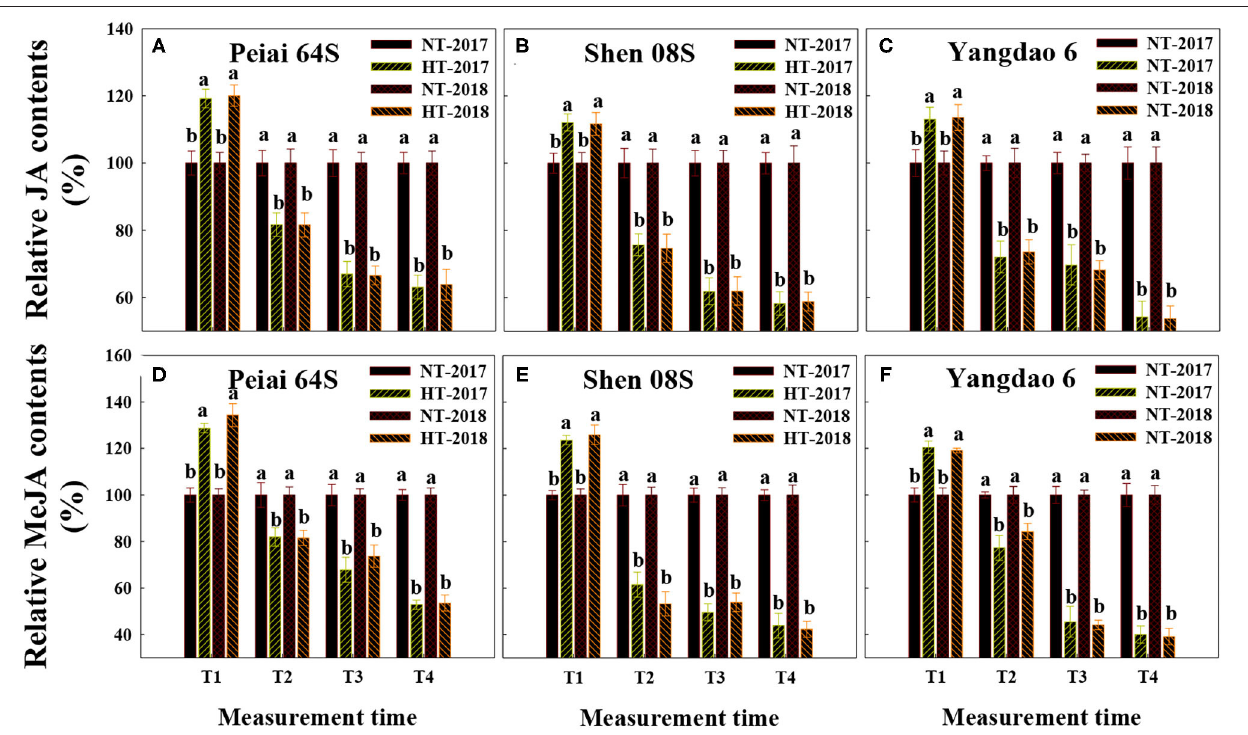
FIGURE 1 | Effect of high-temperature stress during anthesis on the contents of jasmonic acid (JA) (A–C) and methyl jasmonate (MeJA) (D–F) in stigmas of rice. NT and HT represent normal temperature and high temperature, respectively, and the NT is taken as control. Data are expressed as relative values, and those of controls are taken as 100%. T1: 12:00h on the first day during the temperature treatment; T2: 14:00h on the first day during the temperature treatment; T3: 14:00h on the second day during the temperature treatment; T4: 14:00h on the first day after the temperature treatment. The bars are SD of three biological replications. Different letters above the bars represent significant differences at the P ≤ 0.05 level within the same rice line and the same measurement time.